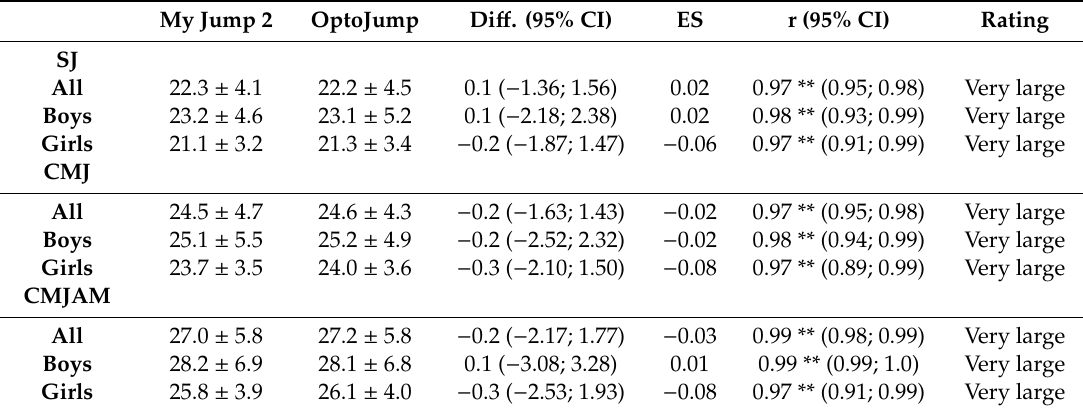
Table 3. Descriptive statistics and validity analysis based on Pearson’s r.